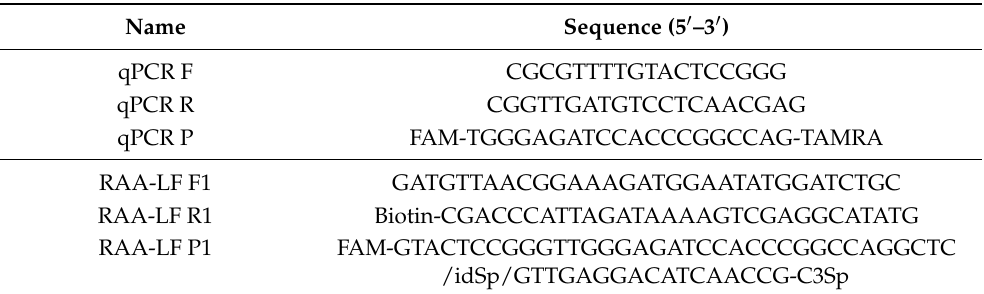
Table 2. Primers and probes to detect VZV using quantitative polymerase chain reaction (qPCR) and recombinase-aided amplification-lateral flow (RAA-LF)